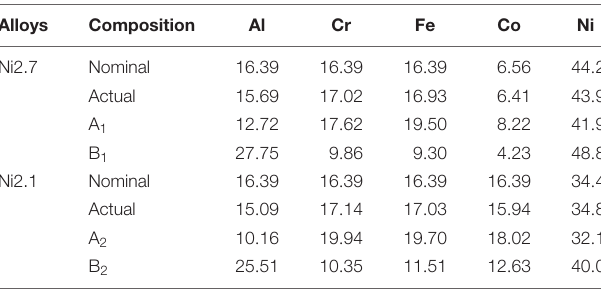
TABLE 1 | Chemical composition of the AlCo x CrFeNi 3 . 1 − x alloys (at. %).